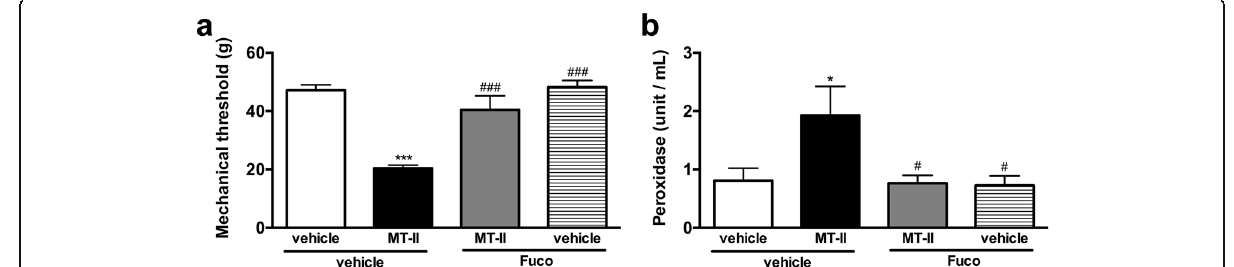
Fig. 3 Effect of a L-selectin binder on MT-II- induced articular hyperalgesia. MT-II (10 μ g/joint) or PBS (vehicle) was injected in tibio-tarsal articulation (25 μ L). Fucoidan (fuco), a L-selectin binder (5 mg/kg, i.v.) or saline (vehicle) was injected 15 min prior to MT-II. a Pain threshold was determined using a modified electronic pressure-meter test 8 h after MT-II injection, and represented as force (in g ). b The neutrophil migration to the tibio-tarsal joint region of mice was evaluated by the myeloperoxidase (MPO) kinetic-colorimetric assay, tested 8 h after MT-II injection. Each point represents the mean± SEM of six animals. * p < 0.05 and *** p < 0.001 indicate statistically significant differences when compared with control group (vehicle +